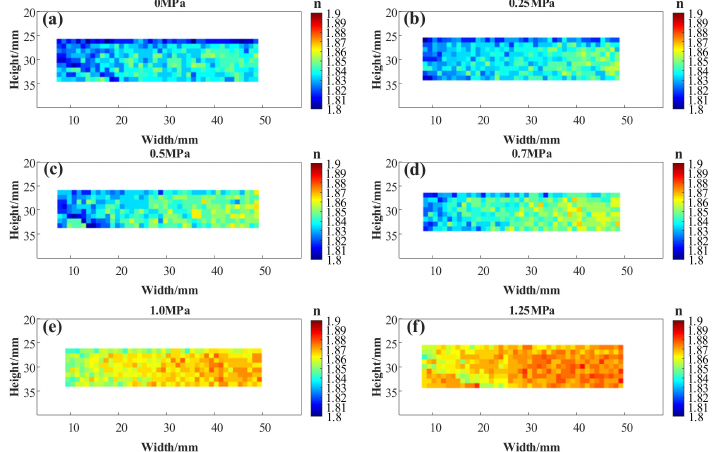
Figure 11. Refractive index distribution of adhesive film under different tensile stress. ( a ) the refractive index distribution under 0 Mpa tensile loads. ( b ) the refractive index distribution under 0.25 Mpa tensile loads. ( c ) the refractive index distribution under 0.5 Mpa tensile loads. ( d ) the refractive index distribution under 0.75 Mpa tensile loads. ( e ) the refractive index distribution under 1.0 Mpa tensile loads. ( f ) the refractive index distribution under 1.25 Mpa tensile